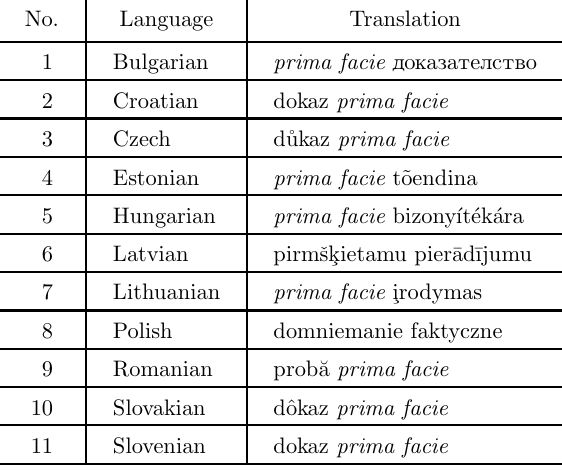
English phrase “prima facie evidence” translated into CEE languages No.